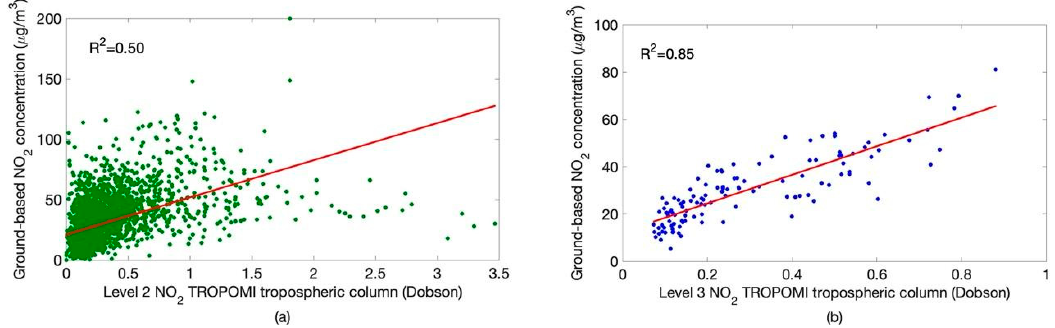
Figure 5. Scatterplot of TROPOMI NO 2 vs. in situ observations for the 10 validation stations in North Italy (see Figure 1). ( a ) Original data; ( b ) after applying the kriging at 1 km × 1 km spatial sampling.